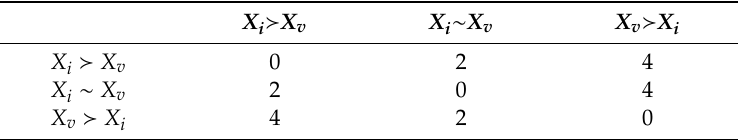
Table 2. Distance between di ff erent alternatives’